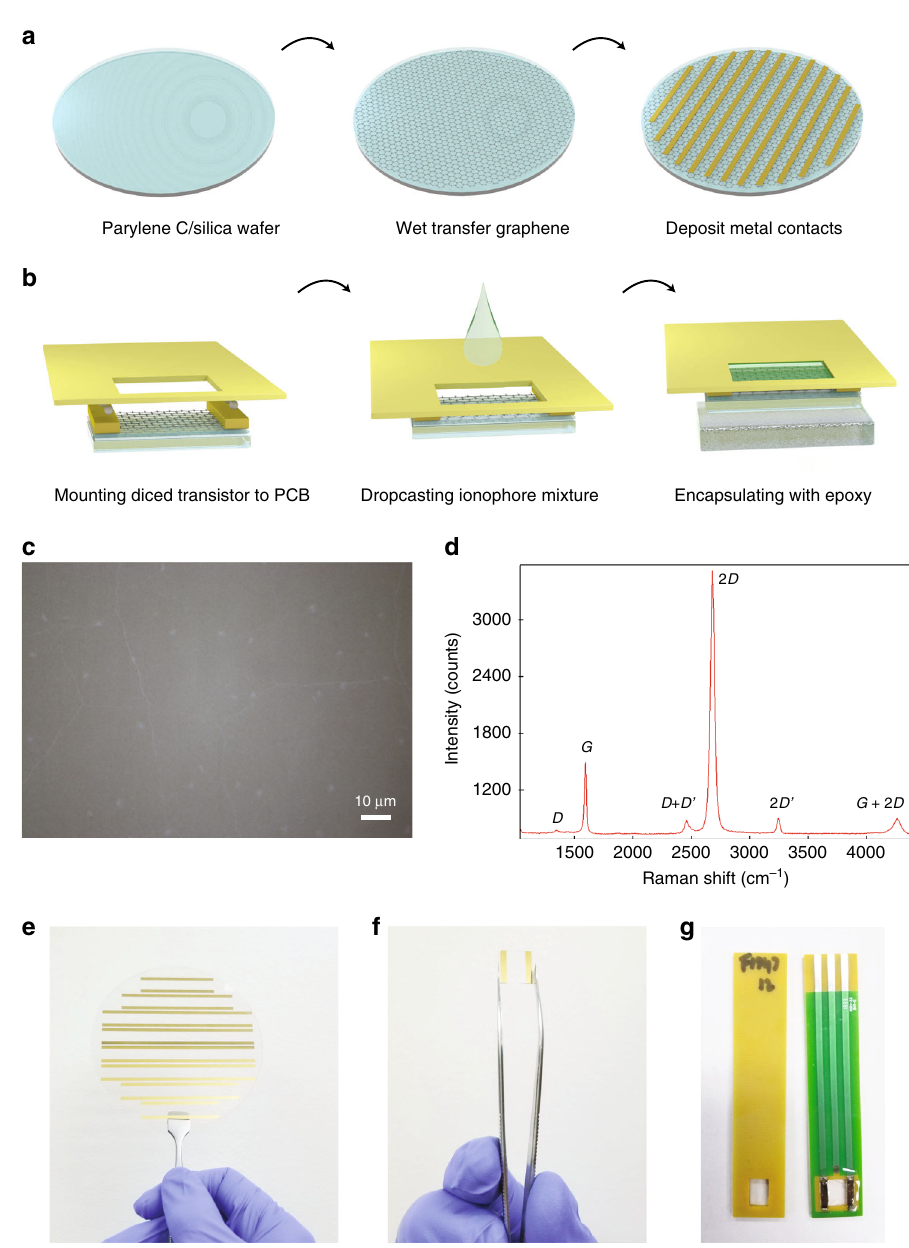
Fig. 1 Graphene ISFET Fabrication. a Schematic of the fabrication process of the graphene ISFETs. 115 nm of parylene C was grown on a 100 mm diameter fused silica wafer. Graphene was grown via CVD on a 100 mm diameter Cu foil and wet-transferred to the target wafer using a PMMA handle. Ti/Au contacts were evaporated with the aid of a shadow mask. b The wafer was then diced into individual 1.1 cm× 1.1 cm devices, which were then mounted onto a PCB using silver epoxy. The ionophore mixture was dropcasted into the opening. Epoxy was used to encapsulate the back gate of the transistor. c Optical image with ×100 magni fi cation of graphene monolayer transferred onto parylene C/fused silca wafer. Scale bar is 10 μ m. d Raman spectra of 100 mm graphene wet-transferred onto target substrate. e An optical image showing a 4" graphene wafer on fused silica and parylene with gold contacts, ready to be diced into individual devices. f A single graphene device after being diced, and ready to be mounted on a PCB. fabrication process. g Top and bottom view of graphene ISFETs mounted on pump wavelength shown in Fig. 1d along with peak After transferring the graphene onto the substrate, Ti/Au (20 assignments 38,39 . The D, G, and 2D peaks are located at 1341 ± 2 cm − 1 , 1593 ± 2 cm − 1 , and 2687 ± 2 cm − 1 , respectively. The D/G Raman intensity ratio is 0.045 ± 0.005 and the G/2D intensity the devices were then mounted on a printed circuit board (PCB) ratio 0.027 ± 0.01, consistent with Raman spectra of monolayer graphene with a low density of defects and grain boundaries 38 . No particular effort was made at single-crystal graphene growth device (Fig. 1b). The PCBs have a 0.8 × 0.5 cm 2 opening for the here, as grain boundaries in polycrystalline graphene have been graphene FET to be exposed to the analyte solution. The 100 mm shown to have a modest effect on graphene sheet resistance 40 . wafer was used to produce 52 graphene FETs, and the average